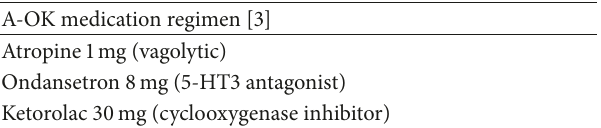
Figure 2: Graph of patient’s vital signs prior and after initiation of A-OK therapy. Table 6: Shamshirsaz and Clark in SOAP 2013 also describe this A-OK therapy with the addition of metoclopramide, which was not used in our patient [15]. The atropine is used to treat vagal overstimulation and improve vasomotor tone while Ondansetron blocks serotonin receptors inhibiting the release of further media- tors [4, 16]. The Ketorolac blocks thromboxane production thereby preventing coagulopathy